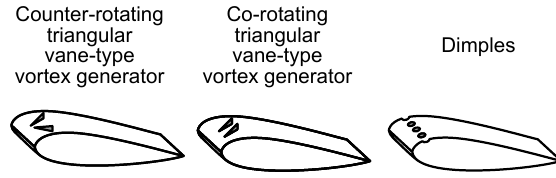
Figure 9. Examples of vortex generators and dimples on an airfoil suction